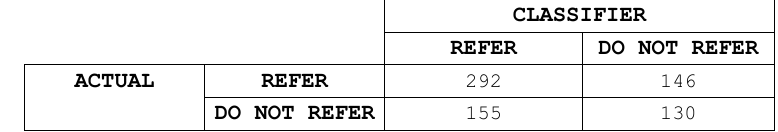
Table 1. A confusion